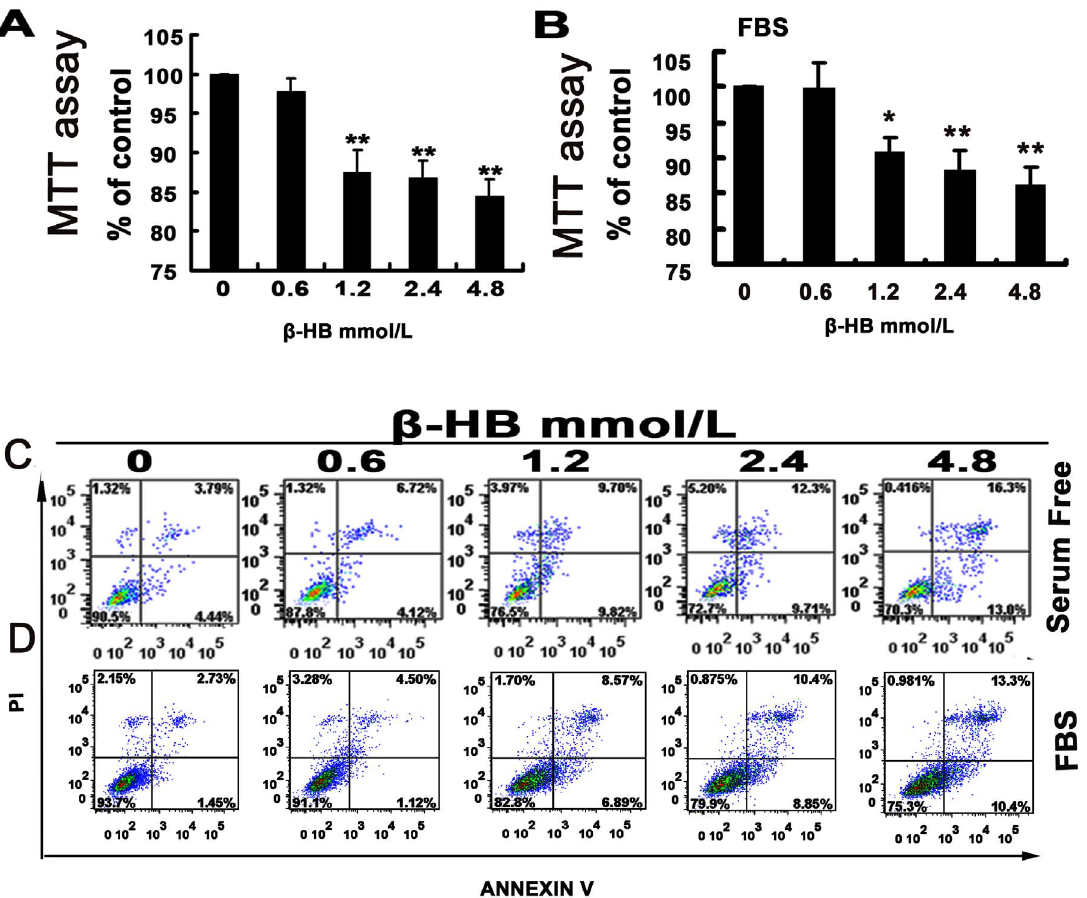
Figure 1. Effect of b -HB on cell death. Cells were incubated 48 h with b -HB (0, 0.6, 1.2, 2.4 or 4.8 mM) in serum-free medium (A and C) or medium with 10% FBS (B and D). A) and B) Cell viability was determined with a MTT assay. Viability was calculated as the percentage of living cells in treated cultures compared to those in control cultures. C) and D) Mortality analysis. The mortality of BSMCs were assayed for with annexin V-FITC by flow cytometry. The mean of three independent experiments is shown. *p , 0.05, **p , 0.01 versus control